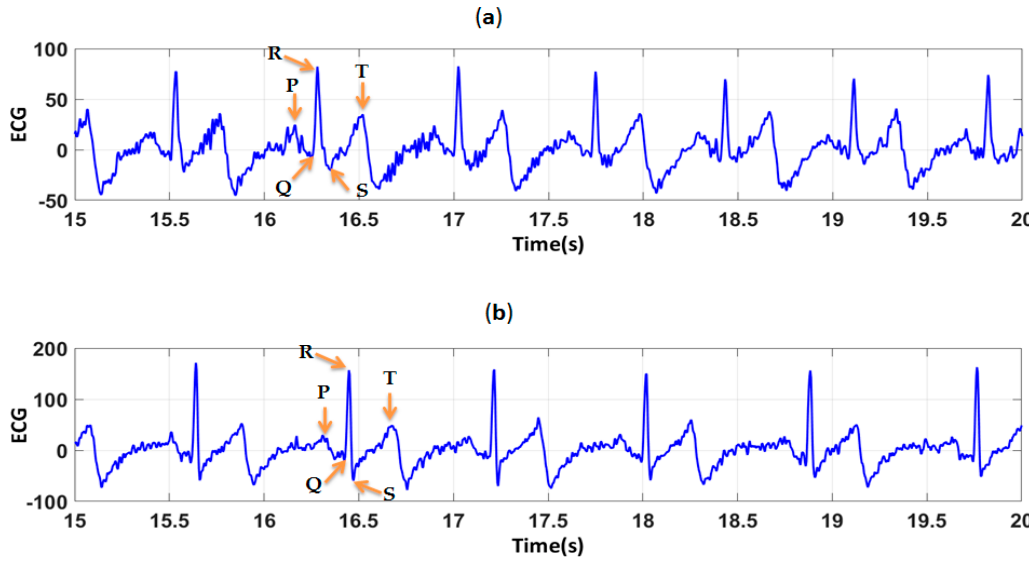
Figure 9. ECG signals, before washing, obtained by ( a ) polyamide textile electrodes coated by S1; ( b ) polyamide textile electrodes coated by S2.